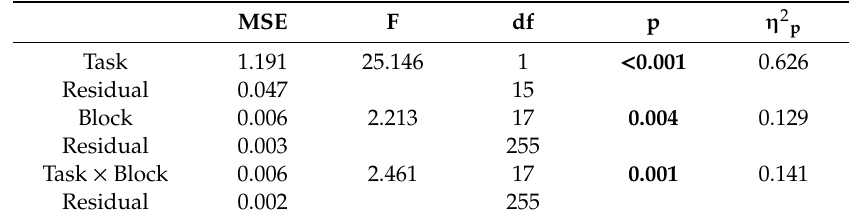
Table A1. Results of the within-participant 2 (task: n-back, oddball) × 18 (block) ANOVA on performance (A’) in the cognitive